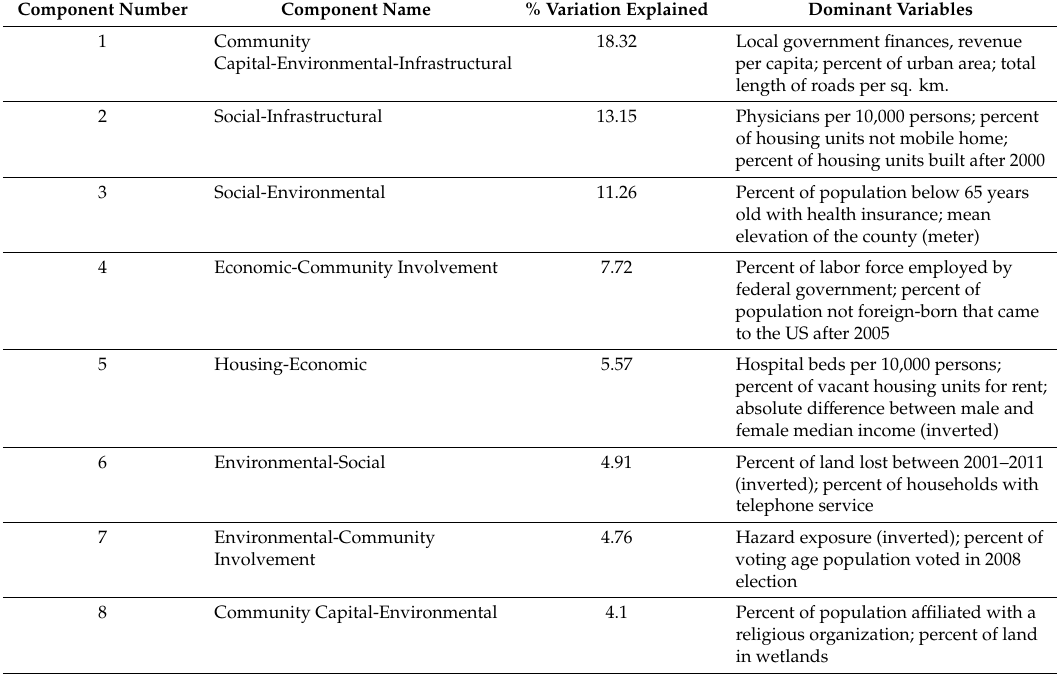
Table 3. Identified components and dominant variables from principal component analysis